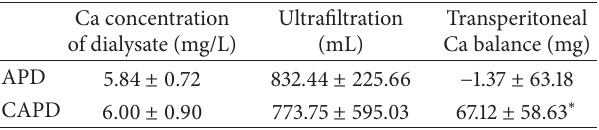
Table 3: Transperitoneal Ca balance and ultrafiltration on succes- sive PD treatment in the same patients.